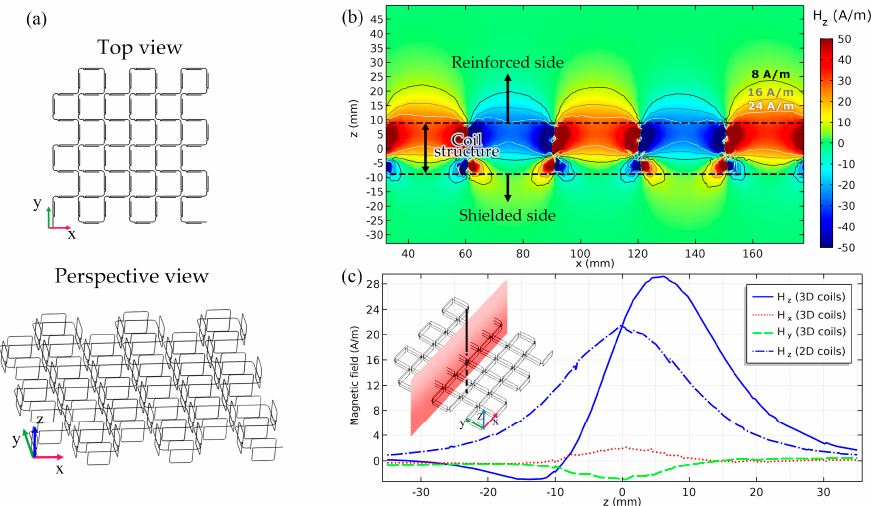
Figure 4. ( a ) Top and perspective views of the entire array scheme. ( b ) The intensity of the z component of magnetic fields in terms of phasors on the plane y = 10.5 cm for a = b = 6 mm, d = 30 mm, and I = 1 A. ( c ) A comparison between the proposed 3D coils and similar traditional 2D coils along the main lobe’s axis at x = y = 10.5 cm and I = 1 A. z < − 7 mm and z > 7 mm indicate the shielded and strengthened zones, respectively. − 7 mm < z < 7 mm is an inaccessible region where the structure is located.